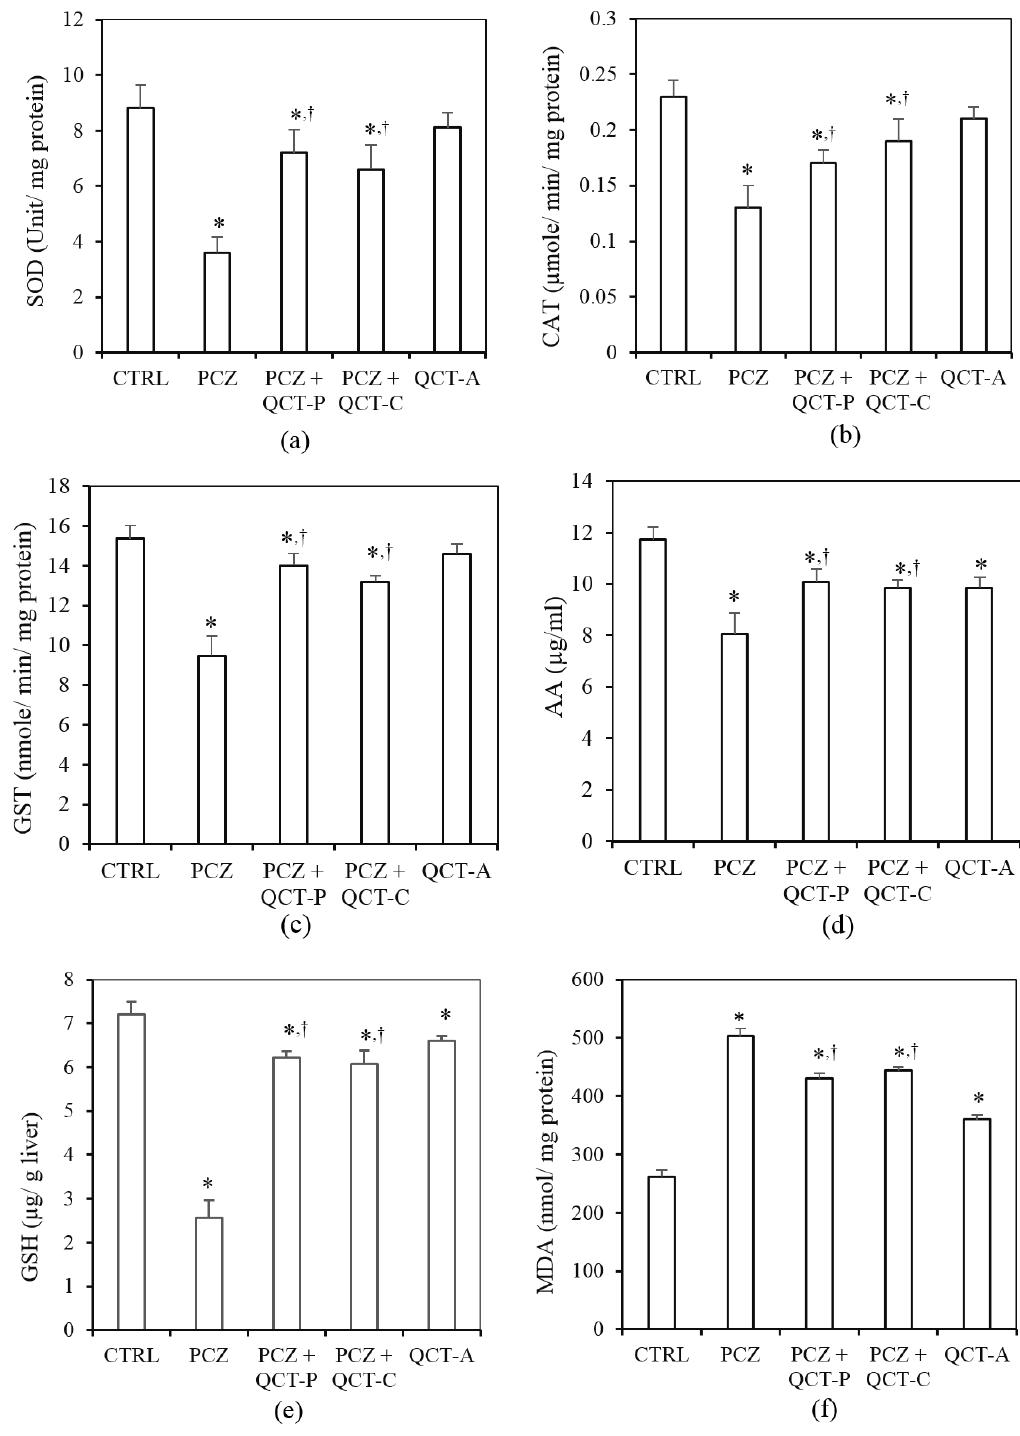
Figure 4. Protective effect of QCT pre-treatment and co-treatment against PCZ-induced changes in hepatic biomarkers of oxidative stress in rats. Data represent the means ± SD for five rats in each group; * significantly different from the CTRL; † significantly different from PCZ ( P <